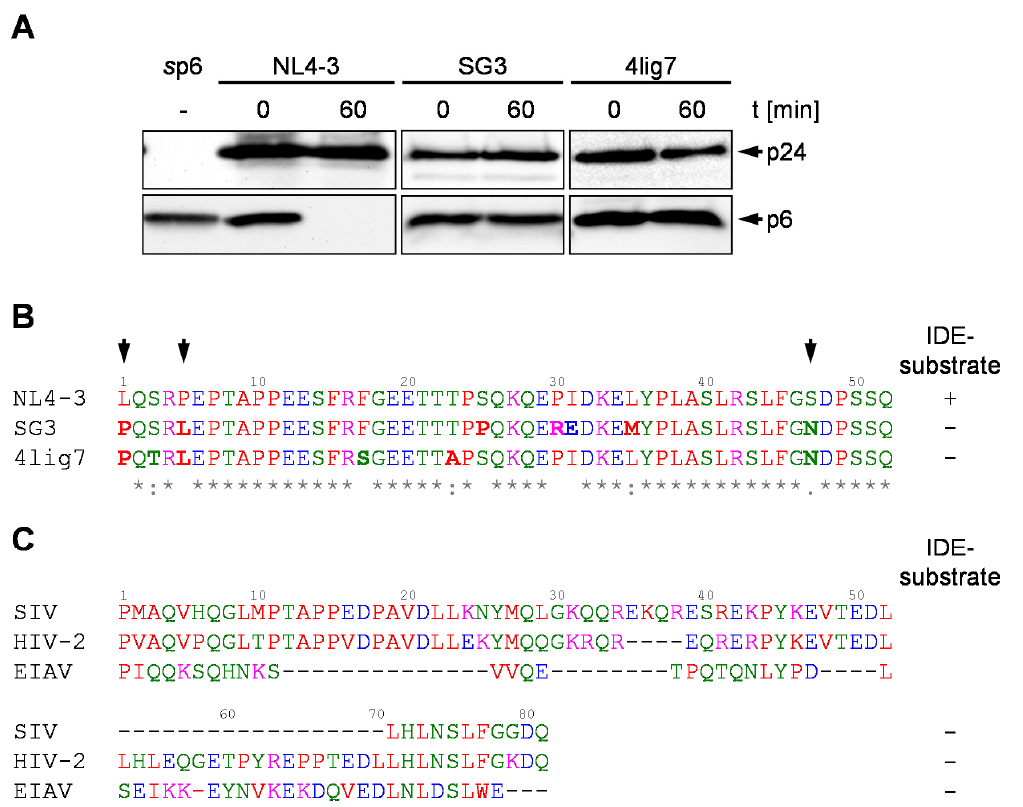
Figure 1. p6 derived from the HIV-1 isolates SG3 and 4lig7 is not degraded by IDE. ( A ) v p6 derived from NL4-3, SG3 or 4lig7 was incubated with S10 extract. p6 and p24 probings were detected by Western blotting. s p6 served as staining control. Representative Western blots of three independent experiments are shown. ( B ) Alignment of the p6 aa sequences of HIV-1 NL4-3, SG3, and 4lig7. Aa that differ in the sequence of SG3 and 4lig7 compared to NL4-3 are written in bold. Common polymorphisms of SG3 and 4lig7 are highlighted by arrows. Conserved aa positions in the sequence alignment are indicated by asterisks. Furthermore, aa exchanges between strongly (colon) and weakly (dot) similar aa residues are specified [45–47]. ( C ) Sequence alignment of IDE insensitive p6 peptides from HIV-2, SIV and EIAV p9 peptide [16]. The sequence of HIV-2 p6 originates from the isolate ROD10, SIV p6 from SIVmac239, and EIAV p9 from the isolate EIAV [16,58]. Colors of Wyoming